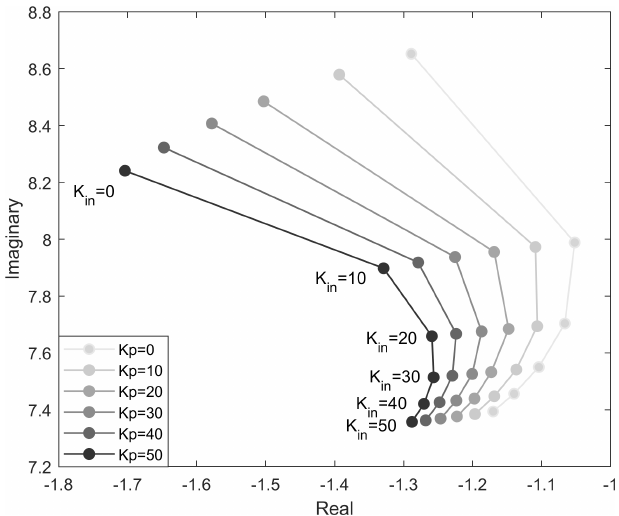
Figure 17. Sensitivity analysis of local modes to K p and K in .